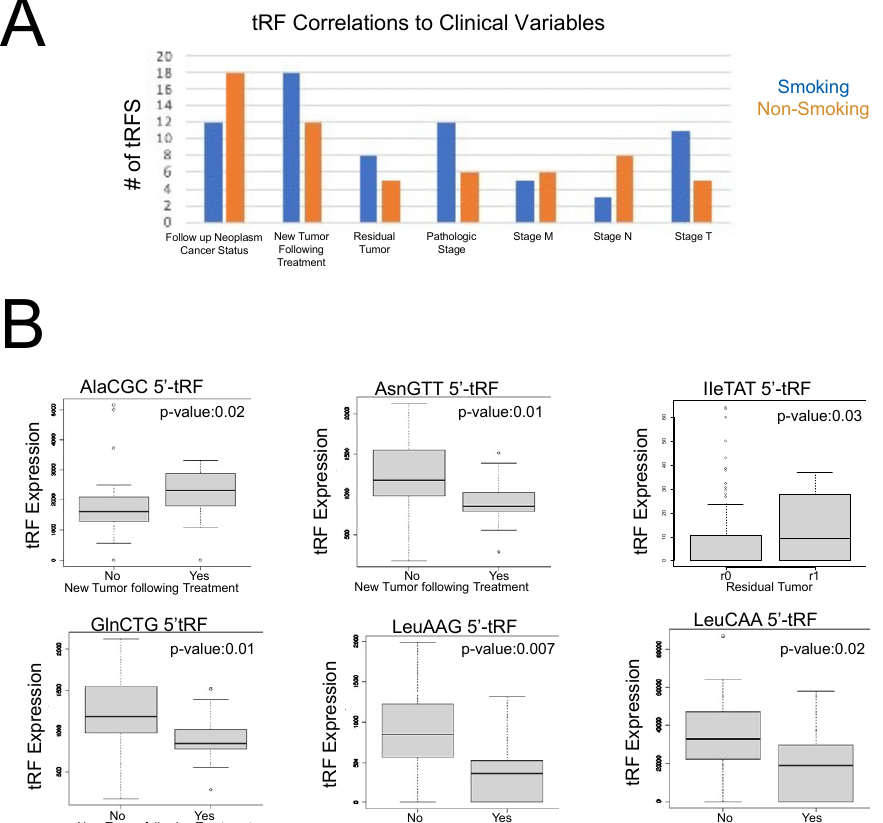
Figure 4. tRF correlations to clinical variables in smoking-induced LUSC and non-smoking-induced LUSC primary tumor samples. tRF correlations to clinical variables were performed using the Kruskal–Wallis test in the edgeR library ( p -value < 0.05). Specifically, the following clinical variables were utilized for the purposes of this study: residual tumor, cancer pathologic stage, cancer pathologic TNM stage, cancer neoplasm status, new tumor event after treatment, and primary therapy outcome. ( A ) Bar graph representing the total number of tRFs associated with the seven clinical variables that displayed significant correlations to tRF expression. Orange represents non-smoking-induced LUSC primary tumor samples, while blue represents smoking-induced LUSC primary tumor samples. ( B ) Select box plots representing tRF correlations to clinical variables ( p -value < 0.05). The x-axis represents a clinical variable, with specific subgroups for the variable, as noted in each graph. The y-axis represents tRF expression. Each box displays the maximum, minimum, median, lower quartile, and upper quartile of tRF expression for each condition. Specifically, by comparing the median tRF expression value between groups, we can draw conclusions regarding the role of tRFs in carcinogenesis and treatment